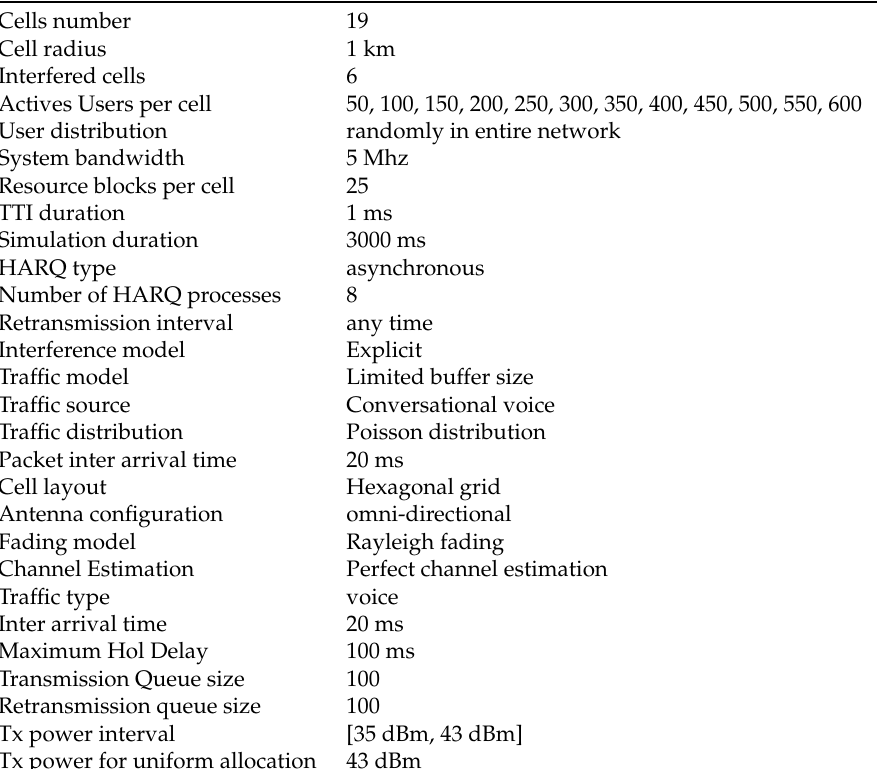
Table 4. System model parameters.